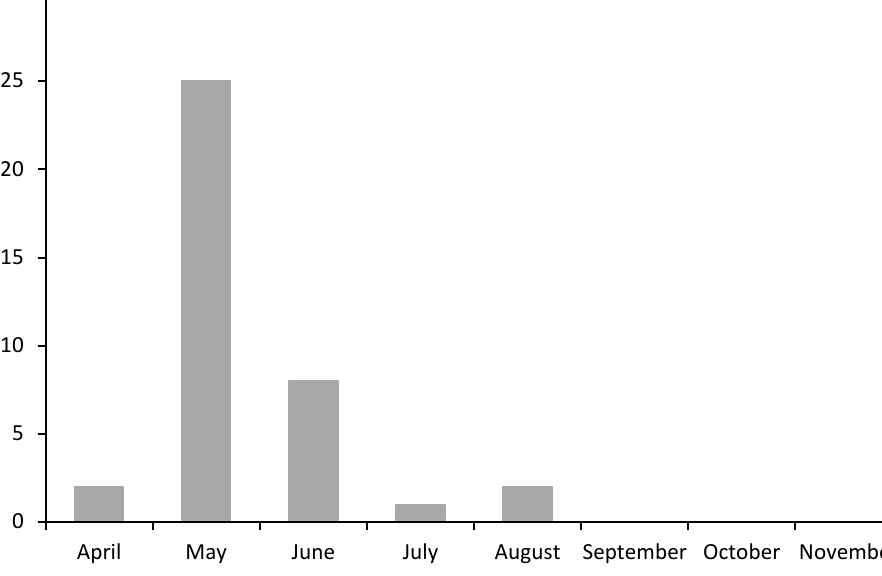
Figure 5. Seasonal dynamics of the Dinaric land leech ( Xerobdella anulata ) based on the literature data and field studies using pitfall traps. The numbers of individuals are pooled per month.